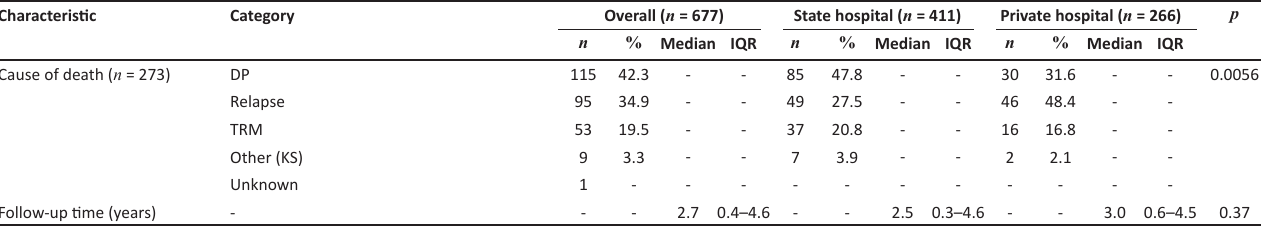
TABLE 1 (Continues...) : Descriptive analysis: State and private hospital. Characteristic